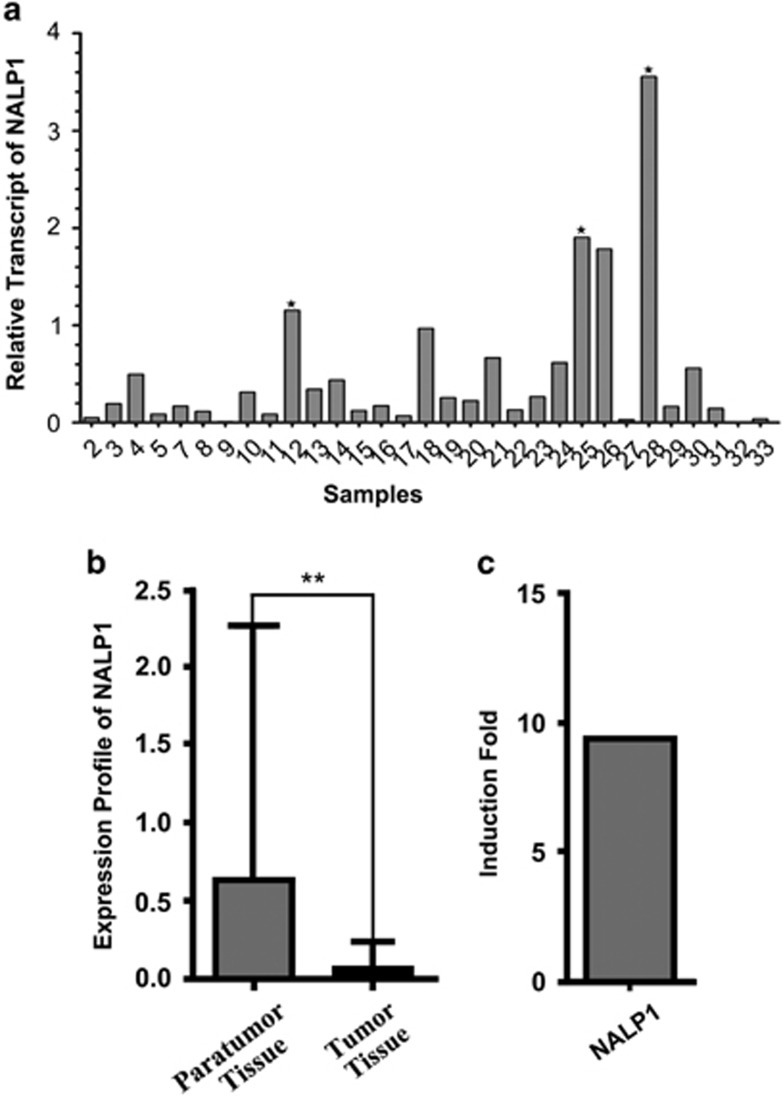
NALP1 mRNA expression in 31 human colorectal cancer tissues. (a) The human colorectal cancer tissue qRT-PCR array was used to measure transcript levels of NALP1 mRNA. For the human tissue array, tissues were selected from 33 individuals with cancer of different stages, except patients 1 and 6. The sample information is described in Table 1. The y axis represents the relative transcript value of NALP1 mRNA. Data were obtained using the comparative CT method, and the data were normalized to GAPDH levels and the matched-pairs normal colorectal tissue. The bar with the sign (★) indicates a relative transcript value >1. (b) The transcript levels of NALP1 in human colorectal normal and cancer tissue, respectively. The qRT-PCR array was used to measure the transcript levels of NALP1 mRNA. The y axis represents the mean±S.D. for human colorectal normal and cancer tissues as individual data points using 2-ΔCt [2-(Ct NALP1-CtGAPDH)]. The S.D. was calculated from these data. The mean±S.D. 2-ΔCt for the normal and cancerous tissues was 0.616±1.642 and 0.066±0.152, respectively, and the difference was highly statistically significant as determined by Wilcoxon signed-rank nonparametric test; the P-values are represented by asterisks (**P<0.01). (c) The fold induction in NALP1 mRNA expression in the human colorectal normal group compared with the human colorectal cancer group. The fold induction is 0.616/0.066- or 9.34-fold. Details are provided in the ‘Materials and Methods' section. GAPDH, glyceraldehyde 3-phosphate dehydrogenase; qRT-PCR, quantitative real-time PCR